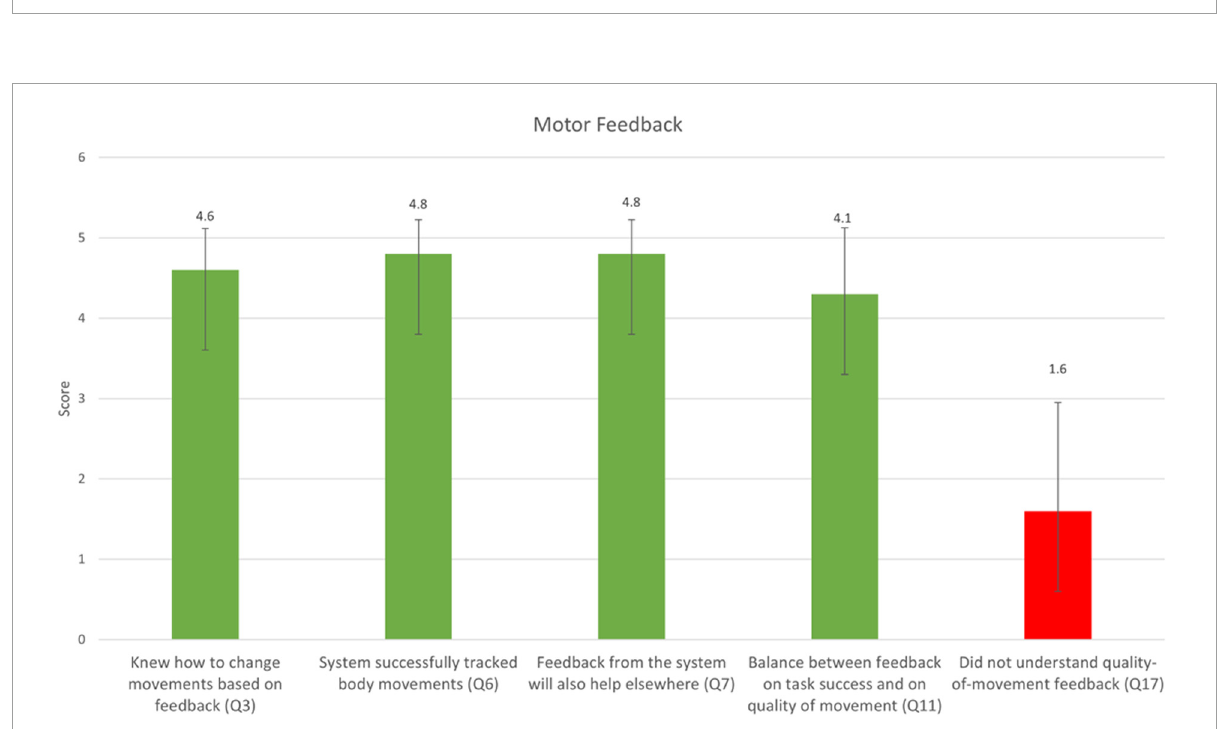
FIGURE5 Responses to the five statements that were only presented in the MF condition (mean ± SD). A score of 1 reflects “Strongly disagree” and 5 reflects “Strongly agree.” The question numbers correspond to the questions listed in Table 2 . The rightmost bar is marked with a different color, as it was negatively worded: a lower score corresponds to higher usability of the